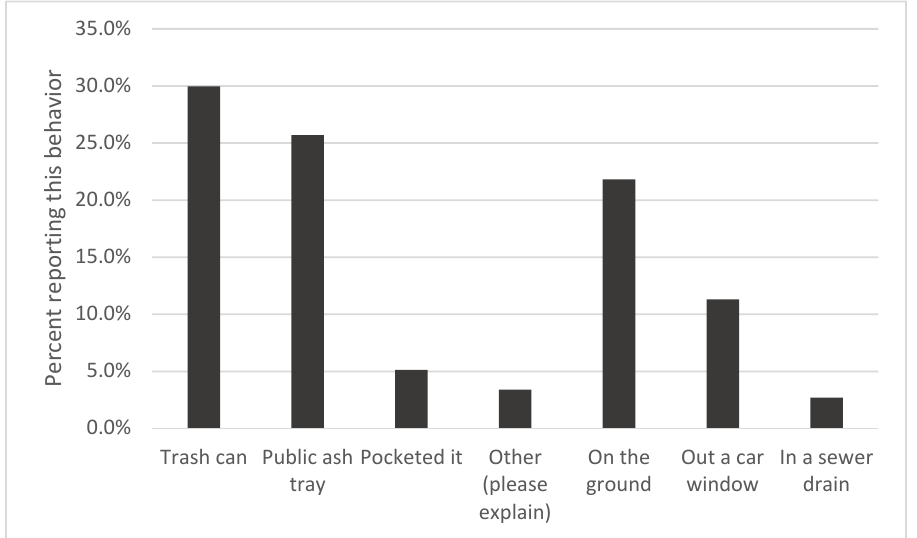
Figure 1. Last cigarette-butt-disposal practices ( n = 7532).